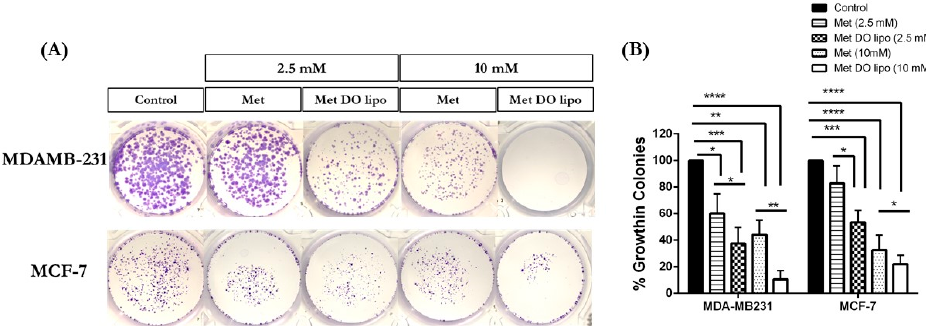
Figure 7. Effect of treatment on colony formation in MDA-MB-231 and MCF-7 cell lines after 24 h of incubation, followed by incubation in fresh media for additional seven days. ( A ) Images of colonies stained with crystal violet. ( B ) Quantification of treatment effect on clonogenic properties of MDA-MB-231 and MCF-7 cells treated with Met and Met DO lipo expressed as % growth in colonies at different dose; 2.5mM and 10mM. Data represent mean ± SD ( n = 3). * p < 0.05, ** p < 0.01, *** p < 0.001 and **** p < 0.0001.